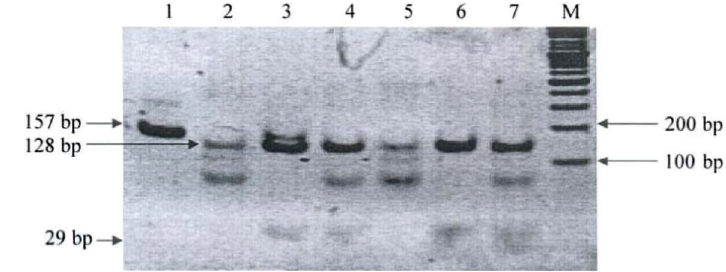
Figure 2. Restriction fragment length polymorph- ism on 12% polyacrylamide gels (acrylamide:bis- acrylamide, 30:0.8) for codon 12. Sample: lane 1 , healthy control, unrestricted (157 bp); lane 2 , wild-type control (128 and 29 bp); lane 3 , heterozygous mutant (157, 128, and 29 bp); lanes 4 to 7 , wild-type K ras (128 and 29 bp); lane M , DNA marker (100 bp, Fermentas).